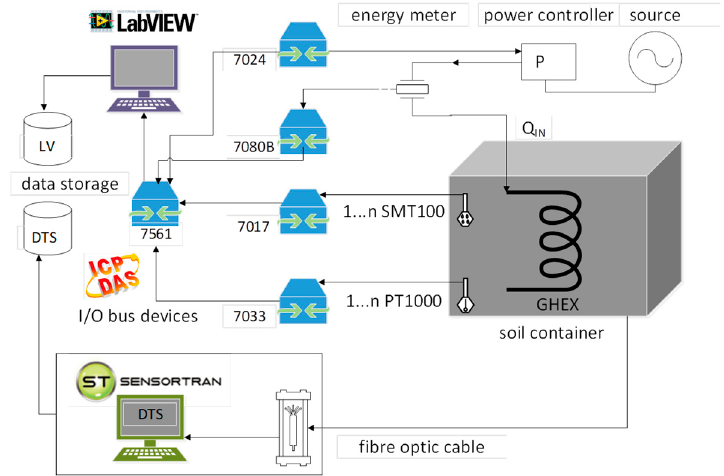
Figure 7. Data acquisition concept.